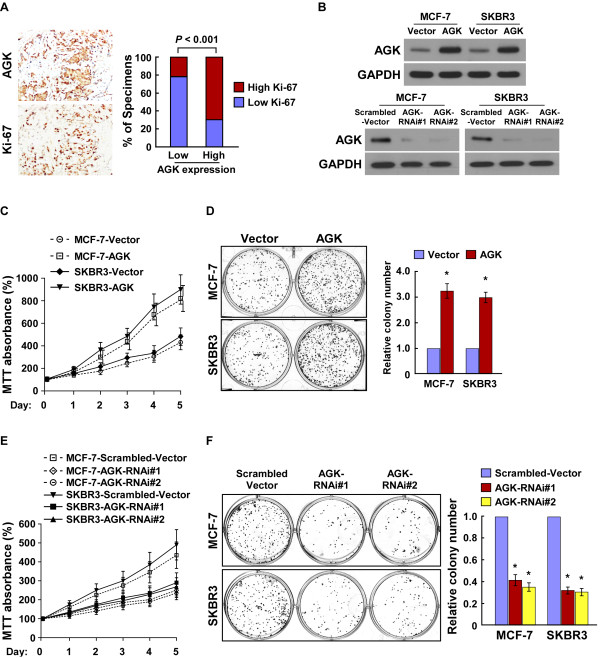
AGK plays a key role in breast cancer cell proliferation and tumorigenicity. (A) AGK expression levels significantly correlated with Ki-67 expression in human breast cancer tissues (n = 203; P < 0.001). Two representative cases are shown (left) and percentage of specimens with low or high AGK expression, relative to the levels of Ki-67 staining (right). (B) Western blotting analysis of AGK expression in AGK-infected MCF-7 and SKBR3 cells (upper panel) and AGK-silenced MCF-7 and SKBR3 cells (lower panel). GAPDH was used as a loading control. (C-F) MTT assay (C, E) and colony formation assay (D, F) indicated that the growth rate increased in AGK-overexpressing cells and decreased in AGK-silenced cells. The absorbance at day 1–5 was normalized to the absorbance at day 0 used as control (100%). The number of colonies was quantified in the colony formation assay. Each bar represents the mean ± SD of three independent experiments. *P < 0.05.